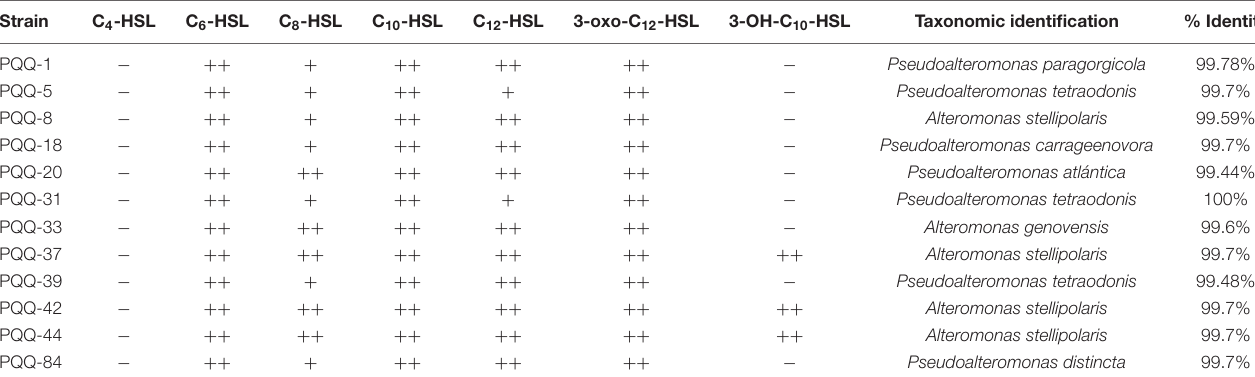
TABLE 1 | Quorum quenching (QQ) activity of the selected marine bacteria and taxonomical identification. Strain